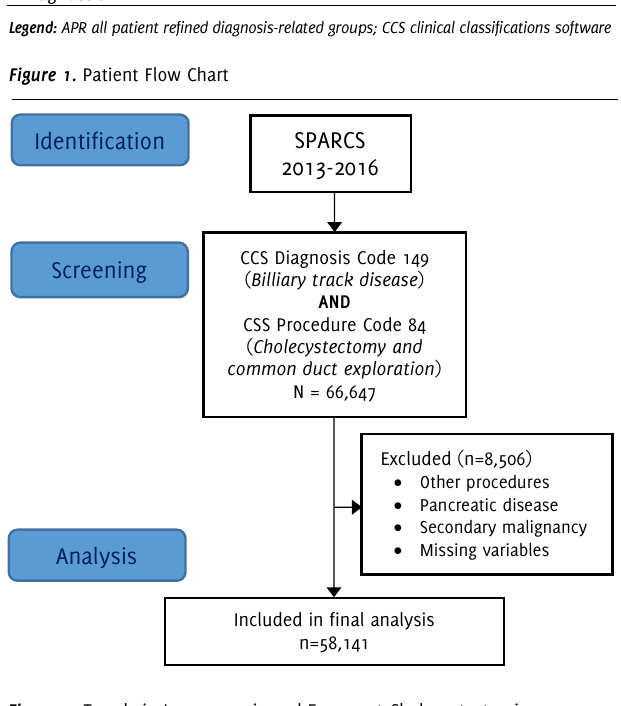
Figure 2. Trends in Laparoscopic and Emergent Cholecystectomies